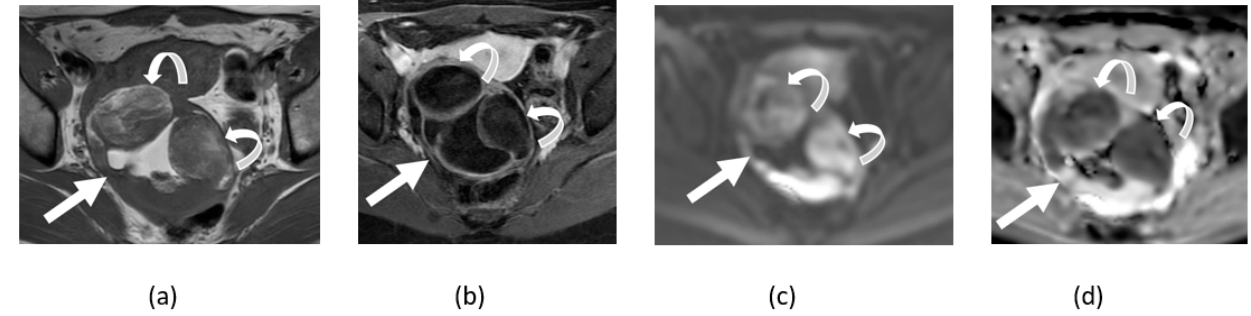
Figure 12. Axial T1-weighted image of pelvis without ( a ) and with ( b ) fat suppression shows fat- containing pelvic lesion consistent with mature cystic teratoma (arrows) showing diffusion restriction in anterior fat-containing component (curved arrows) on corresponding DWI ( c ) and ADC map ( d ) images.